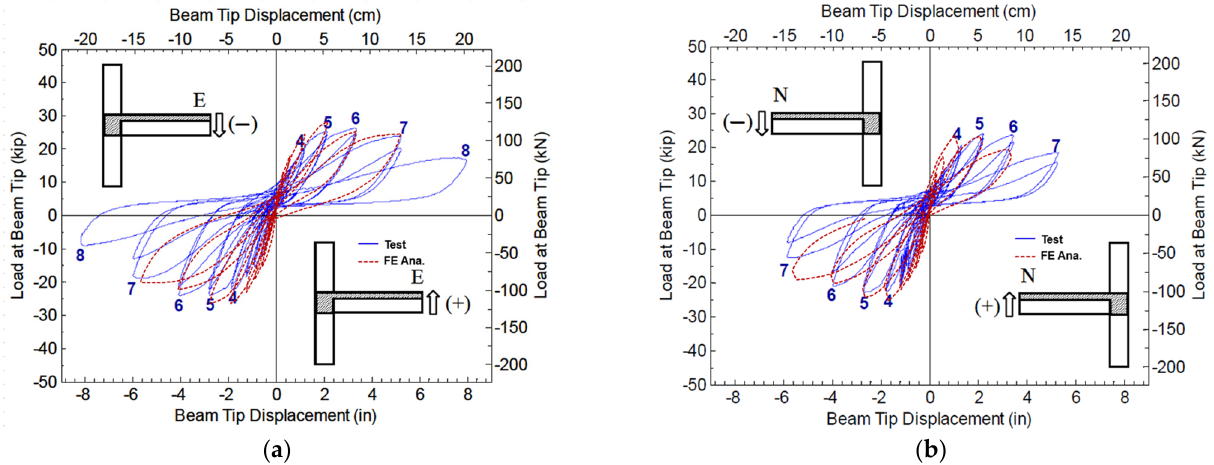
Figure 9. Comparison of load–displacement curves obtained from FE analysis with test observation ( a ) E–W direction, ( b ) N–S direction.